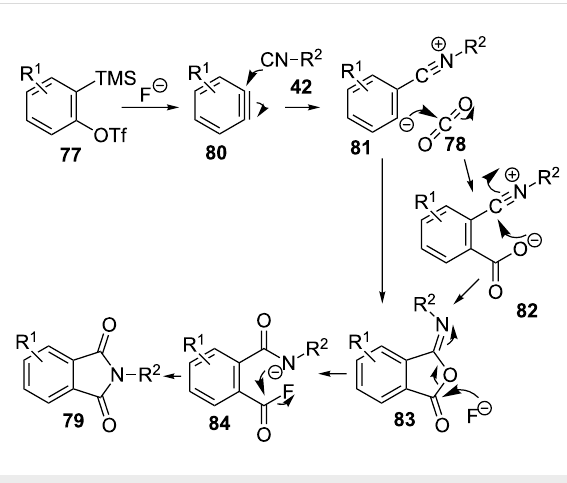
The plausible mechanism for this transformation (Scheme 24) would start with the formation of the reactive aryne 80 which is first trapped with the nucleophilic isocyanide to form 81 and produce the corresponding isobenzofurane 83 , which alterna- tively, could also be formed by a concerted pathway. Then the fluoride induced ring opening and subsequent cyclization of intermediate 84 would generate phthalimide 79